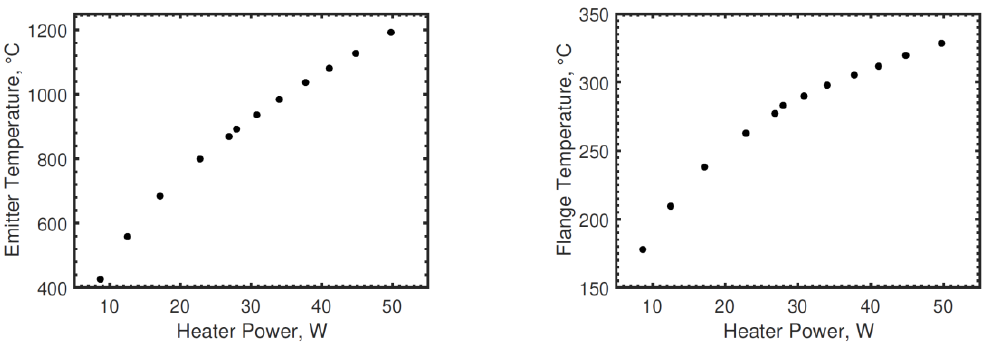
Figure 6. Emitter (left) and interface flange (right) temperatures as a function of heater